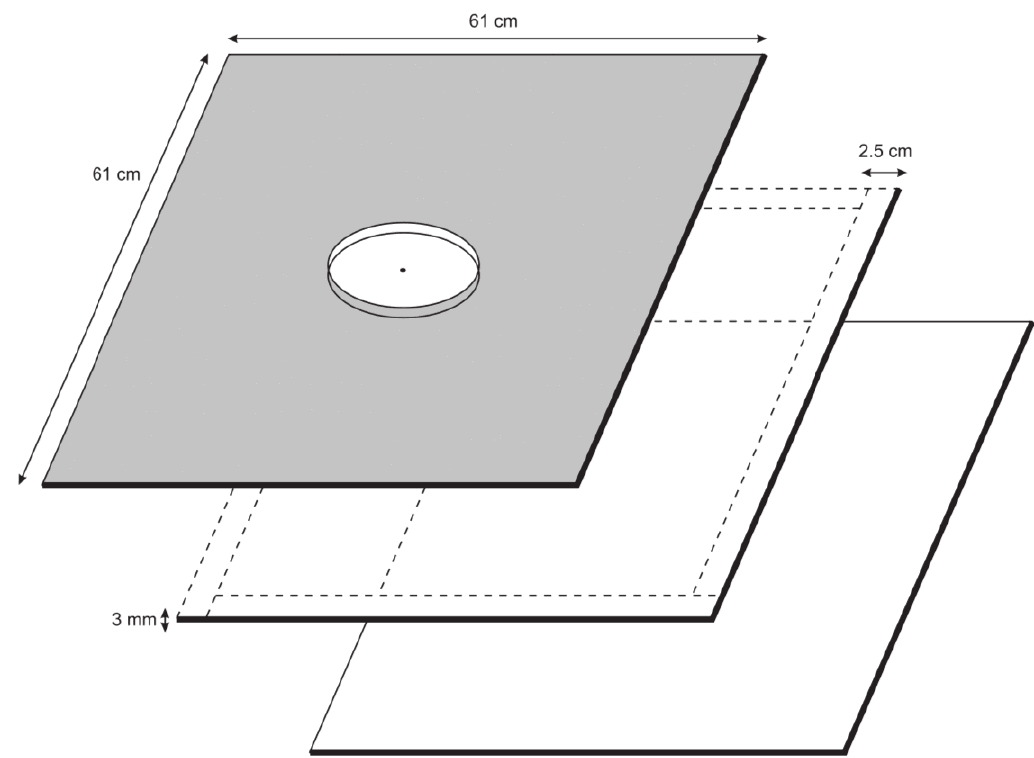
Figure 1. Tunneling arena (61 × 61 cm) constructed of two sheets of transparent Plexiglas (61.0 × 61.0 cm) separated by four Plexiglas strips (61.0 × 2.5 × 0.3 cm) affixed to the outer margins with screws. One access hole (6.5 cm diameter) was drilled at the center of the top sheet and fitted with an ant release